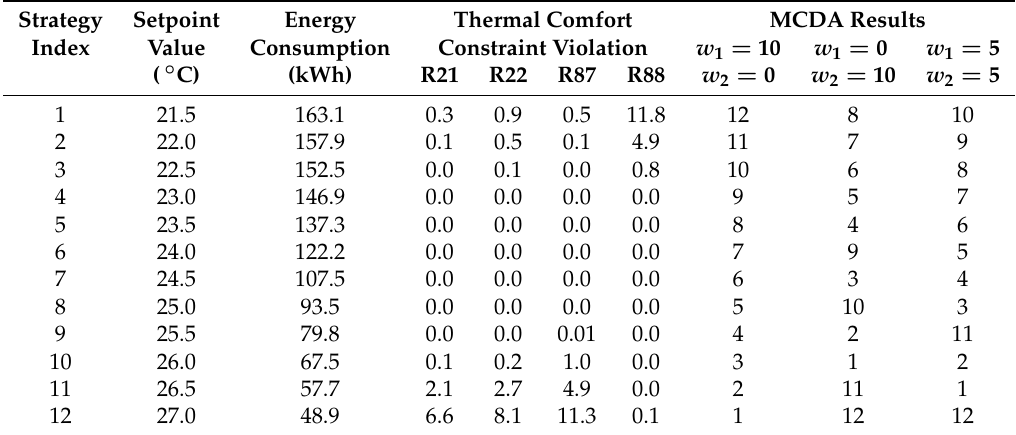
Table 1. The evaluation of different control strategies in the simulation model. Here, the thermal comfort constrained violations are calculated using Equation (11) for the entire occupied period. Strategy Setpoint Energy Thermal Comfort MCDA Results Index Value Consumption Constraint